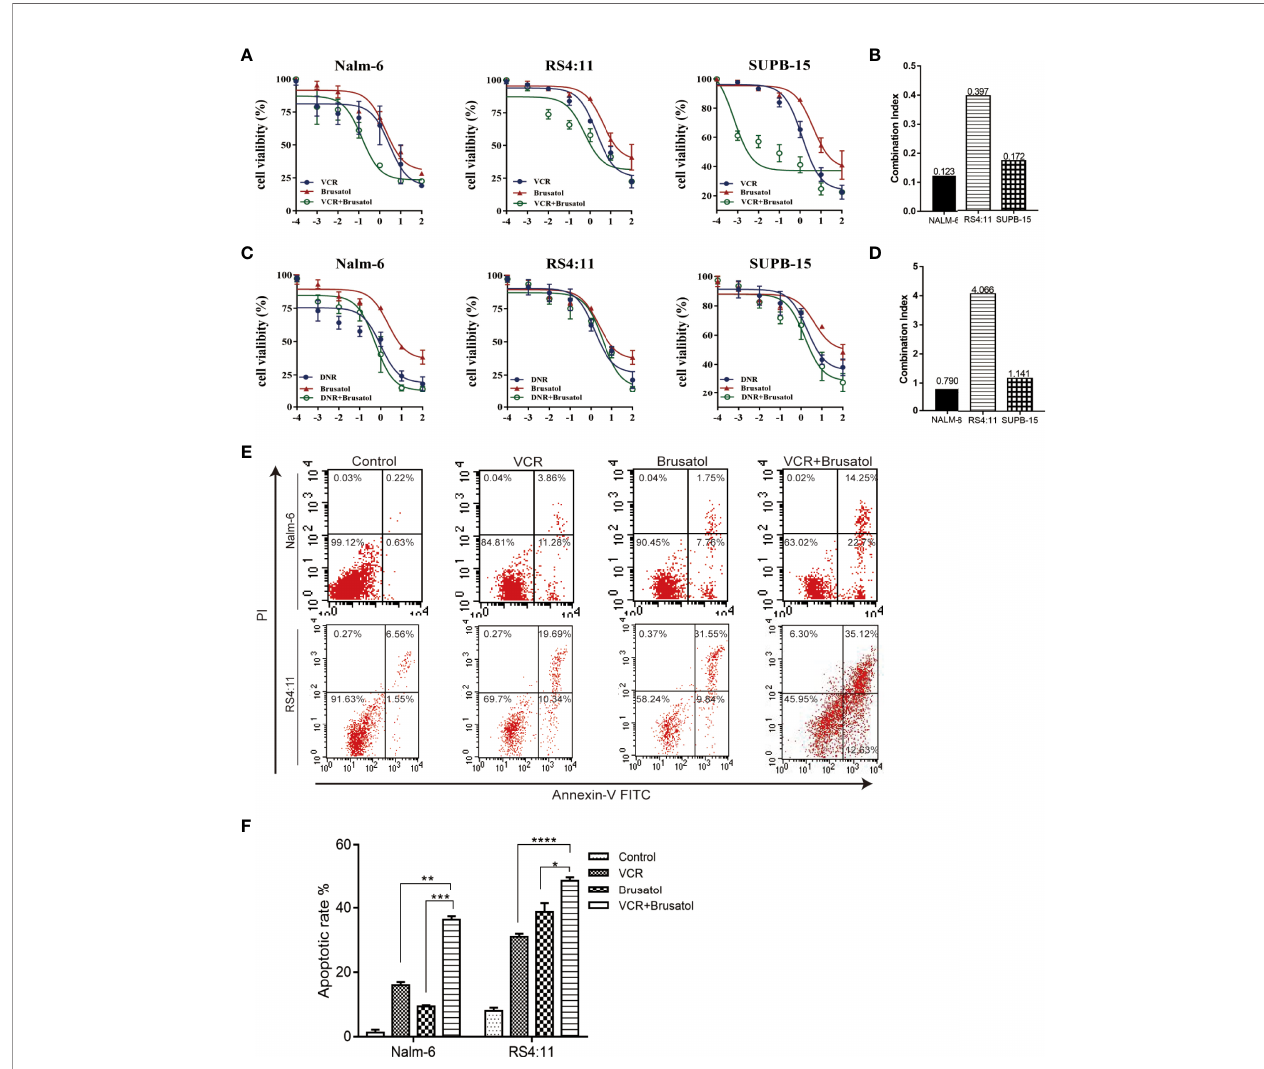
FIGURE 2 | Nrf2 inhibitor, brusatol, sensitises B-ALL cell lines to VCR. (A) Dose-response curves of VCR(10 -4 ,10 -3 , 10 -2 , 10 -1 , 10 and 10 2 m M), brusatol (10 -5 , 10 -4 ,10 -3 , 10 -2 , 10 -1 and 10 m M) and VCR (10 -4 ,10 -3 , 10 -2 , 10 -1 , 10 and 10 2 m M) combination at the constant molar ratio with brusatol (1.5 m M) in B-ALL cell lines. CCK-8 assay after 24 h of drug exposure determined cell viability. (B) Combination index (CI) values were calculated for each drug combination at effective dose ED50. (C) Dose-response curves of DNR (10 -4 ,10 -3 , 10 -2 , 10 -1 , 10 and 10 2 m M), brusatol (10 -5 ,10 -4 ,10 -3 , 10 -2 , 10 -1 and 10 m M) and DNR (10 -4 ,10 -3 , 10 -2 , 10 -1 , 10 and 10 2 m M) combination at the constant molar ratio with brusatol (1.5 m M) in B-ALL cell lines. CCK-8 assay after 24 h of drug exposure determined cell viability. Data are expressed as mean ± S.E.M. of at least three independents ’ experiments. (D) Combination index (CI) values were calculated for each drug combination at effective dose ED50. (E, F) The combined VCR (5 m M)/brusatol (1.5 m M) treatment increases apoptosis in B-ALL cell lines for 24h. An Analysis of apoptosis (by Annexin-V/PI staining) induced by brusatol, VCR, and their combination (at same molar ratios as in A and C) at the indicated concentrations 24 h post-treatment. *P < 0.05, **P < 0.01, ***P < 0.001,****P <